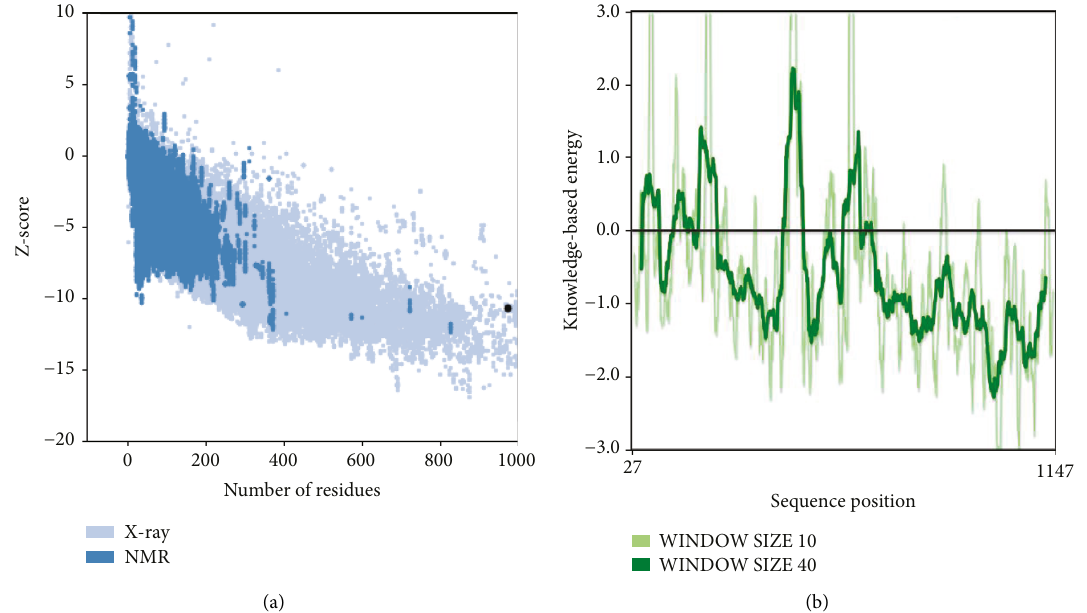
Figure 7: ProSA output for SARS-CoV-2-SG. (a) Overall model quality with ProsaWeb server and (b) local model quality with ProsaWeb server.